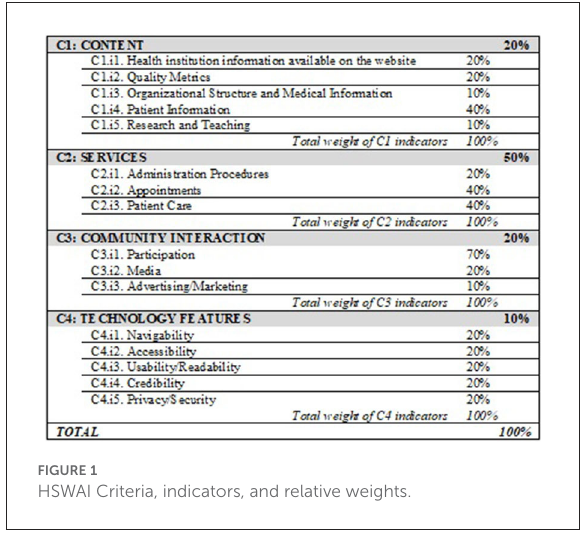
P values of all the sub _ indicators number of sub _ indicators 6= ′′ not applicable ′′ / total number of sub _ indicators